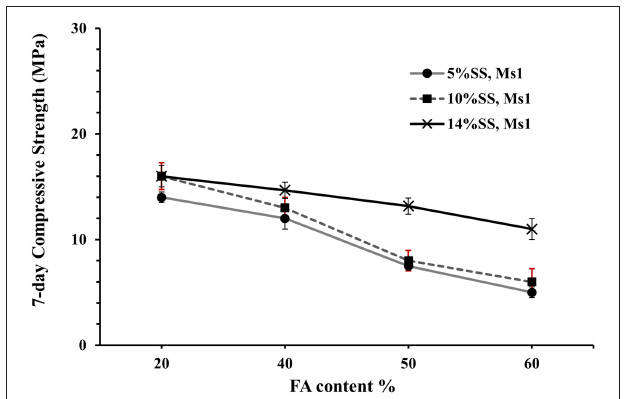
FIGURE 4 | Effect of adding fly ash on 7-day compressive strength for AASF concrete cubes activated by different doses of sodium silicate as marked, with alkali modulus 1.